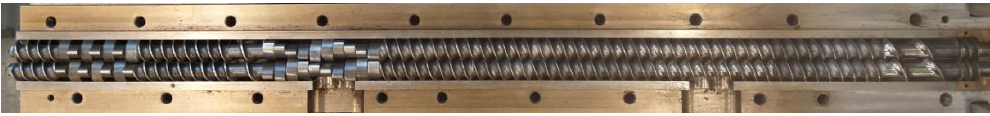
Figure 1. The appearance of an open plasticizing system of an extruder with processing